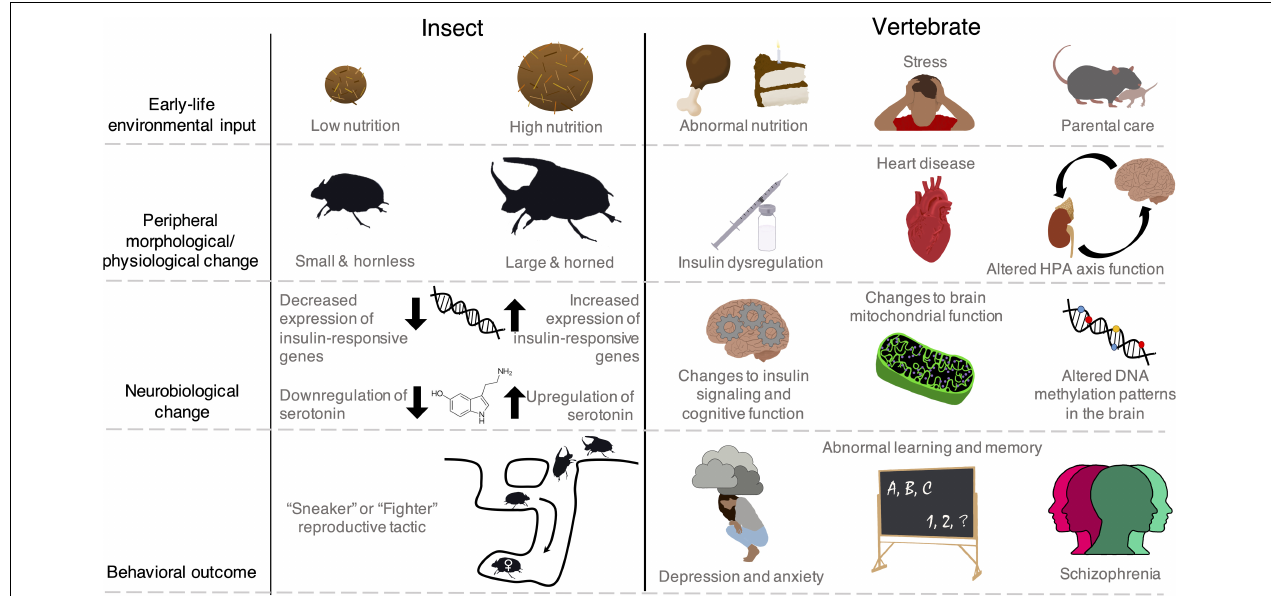
FIGURE 1 | The impacts of early-life experiences extend beyond the brain to peripheral physiological systems and even body morphology in insect and vertebrate species. The brain and peripheral systems interact to shape adult behavioral expression in ways that remain poorly understood. Though these brain-peripheral connections are common across animals including vertebrates, and specifically humans, some insects show particularly conspicuous and discrete changes in morphology, presenting interesting systems to investigate behavioral regulation. Moreover, despite the more noticeable phenotypic differences in some insects, there are examples of common regulatory mechanisms (e.g., insulin signaling) that underpin behavioral dynamics across the insect and vertebrate phylogenetic space. Left: In some beetles ( Onthophagus spp. ), males that are provided high amounts of nutrition during development emerge as large adults with horns (Emlen, 1997). Horns give males a benefit in competition over female mates, which nest in sub-terranean tunnels under dung piles (Moczek and Emlen, 2000). These morphological changes are associated with changes in brain insulin and serotonin signaling (Snell-Rood and Moczek, 2012; Newsom et al., 2019) and result in two distinct male reproductive tactics. Large, horned males will guard female tunnels and compete with other rivals, while small, hornless males dig side tunnels and sneak around large males to reach the female (Emlen, 1997; Moczek and Emlen, 2000). Right: In vertebrates, early-life nutrition, stress, and social interactions cause coordinated changes in peripheral physiological function (Barker, 1995; Champagne and Curley, 2005; Avitsur et al., 2015) as well as brain hormone signaling, bioenergetics, and gene regulation (Hochberg et al., 2011; Korosi et al., 2012; Hoffmann and Spengler, 2018). These changes can give rise to cognitive and mental